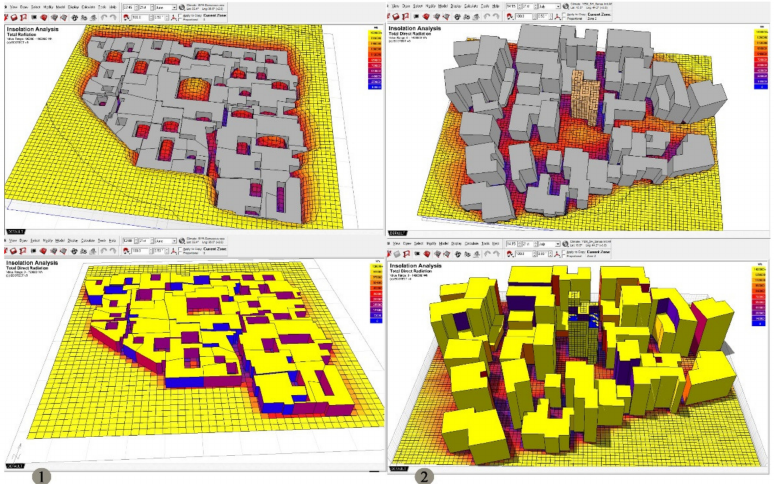
Figure 8. Incident solar analysis of urban fabric in ( 1 ) old Damascus, ( 2 ) old